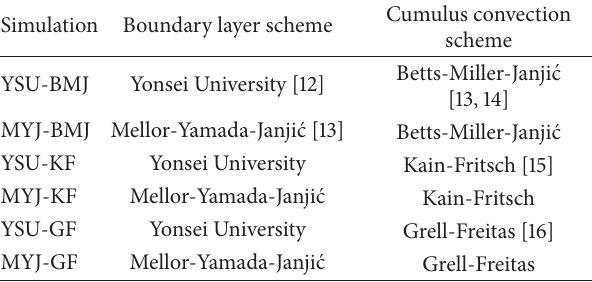
Table 1: Set of simulations with the ARW-WRF model combining distinct physical parameterization